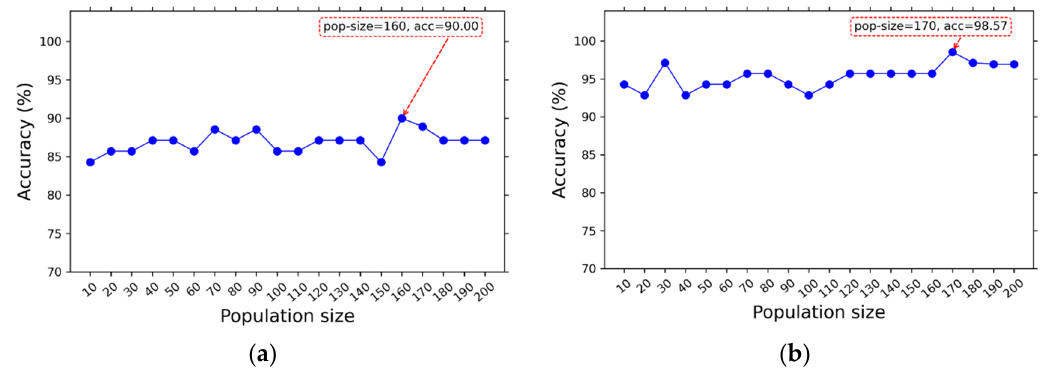
Figure 4. XGboost model accuracy with respect to population size ( pop-size ) for dataset ( a ) I (multi-class) and ( b ) II (binary-class).